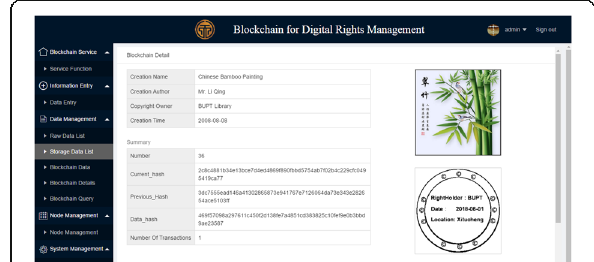
Fig. 9 DRMChain block data instance